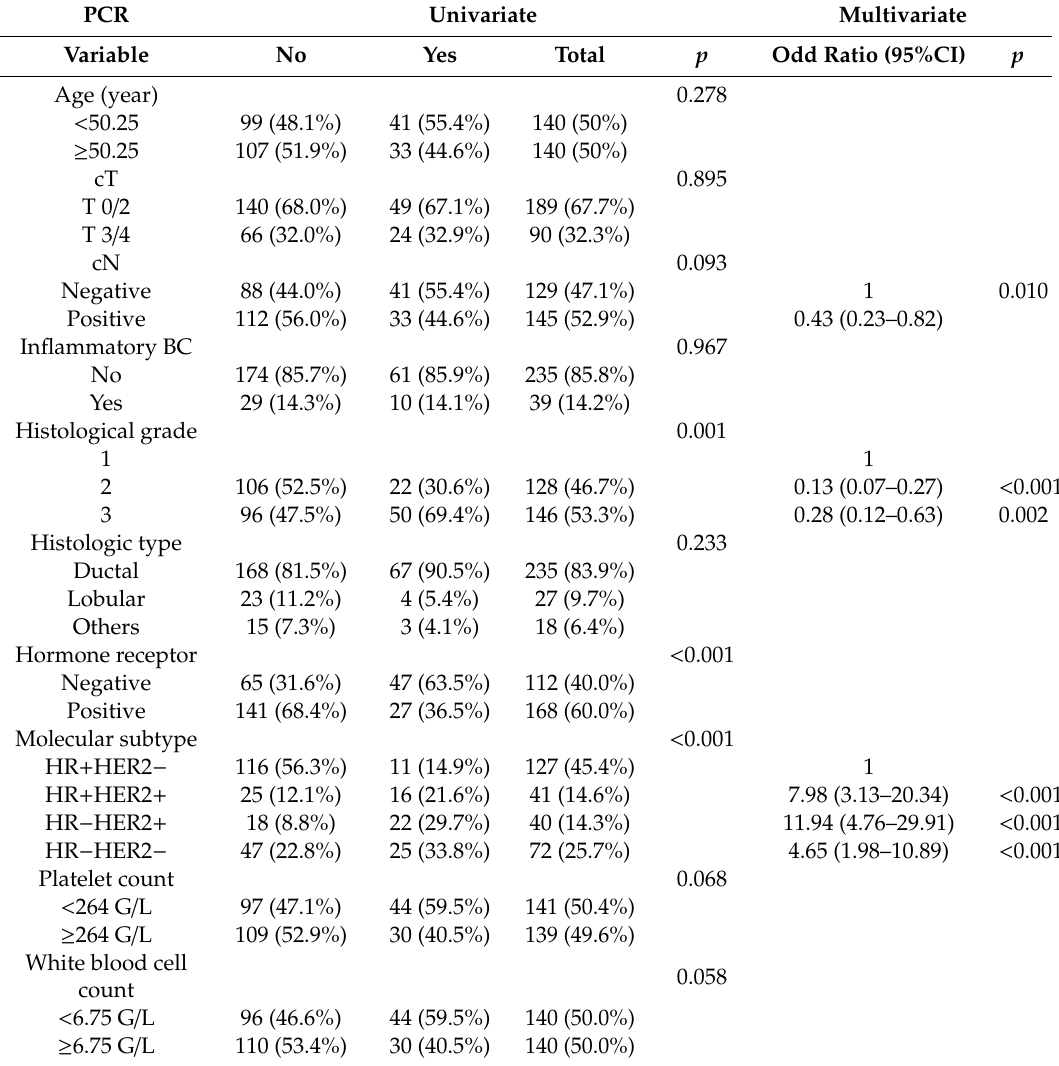
Table 2. Univariate and multivariate logistic regression of predictive factors for pathological complete